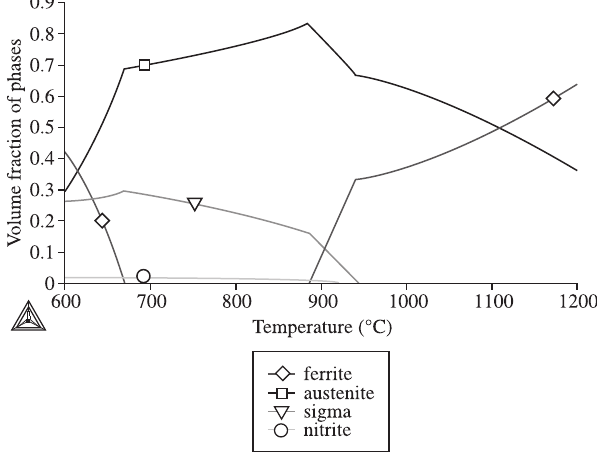
Figure 6. Ferrite and sigma phase content (vol. %) as a function of aging time at 850 °C.